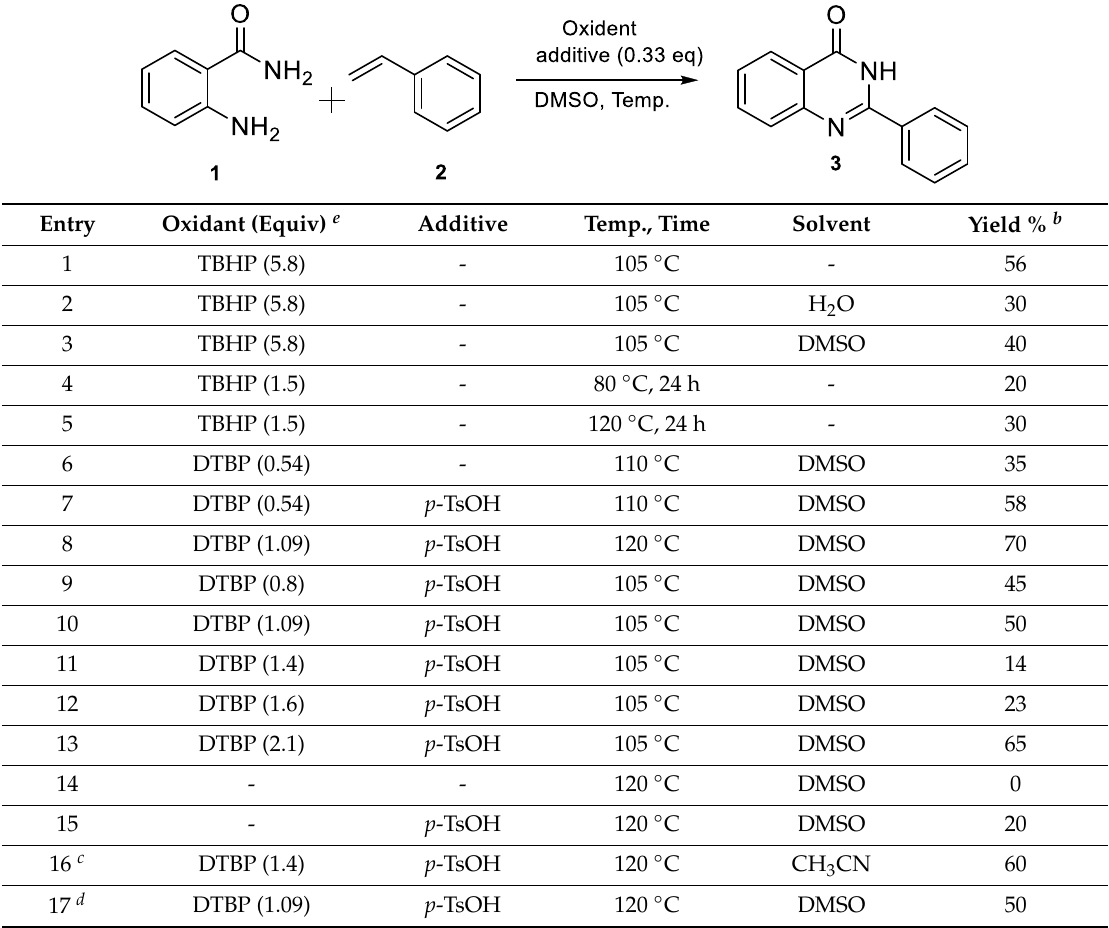
Table 1. Model reaction for synthesis of quinazolin-4(3H)-one a .